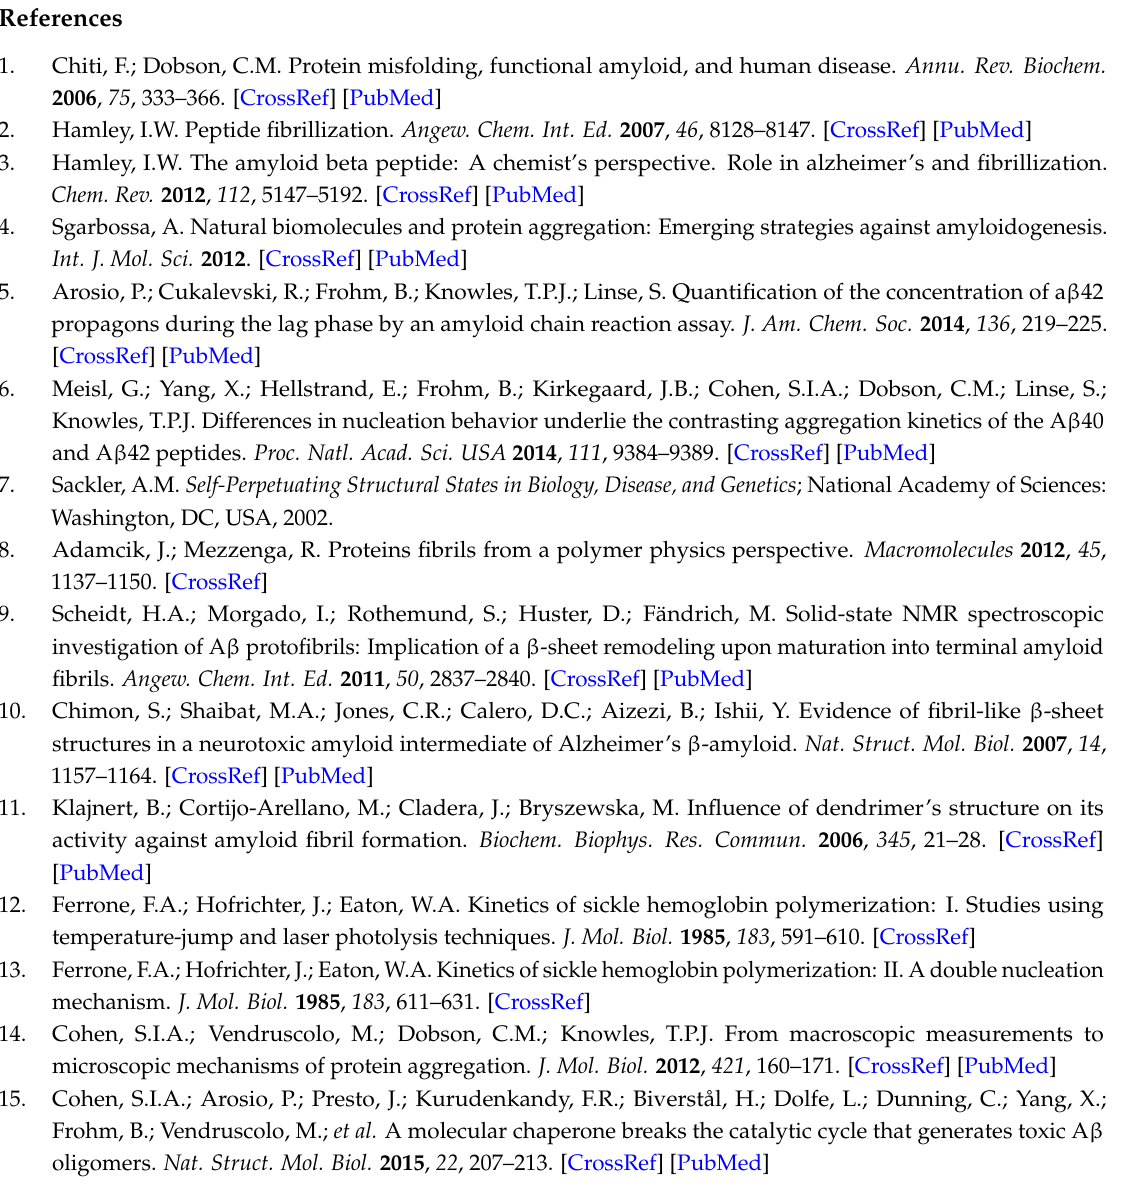
Figure S1: MALDI of 3a , Figure S2: 1 H-NMR spectrum of 3a , Figure S3: 1 H-NMR spectrum of propargyl-initiated P i PrOx 6a , Figure S4: 1 H-NMR spectrum of propargyl-initiated P i PrOx 7, Figure S5: 1 H-NMR spectrum of methyl-initiated P i PrOx 8 , Figure S6: 1 H-NMR spectrum of P( n BuOx- grad - i PrOx) 9 , Table S1: Characterization of P( n BuOx- grad - i PrOx) copolymers 9 , Table S2: Concentration dependency of the LCST for P i PrOx 7 , Figure S7: LCST curves for the P( n BuOx- grad - i PrOx) copolymers 9 (in buffer), Figure S8: Molecular weight dependency of the LCST for poly(methoxy di ( ethylene glycol)acrylates ) 3 (in water), Figure S9: Molecular weight dependency of the LCST for poly(methoxy di ( ethylene glycol)acrylates ) 3 (in